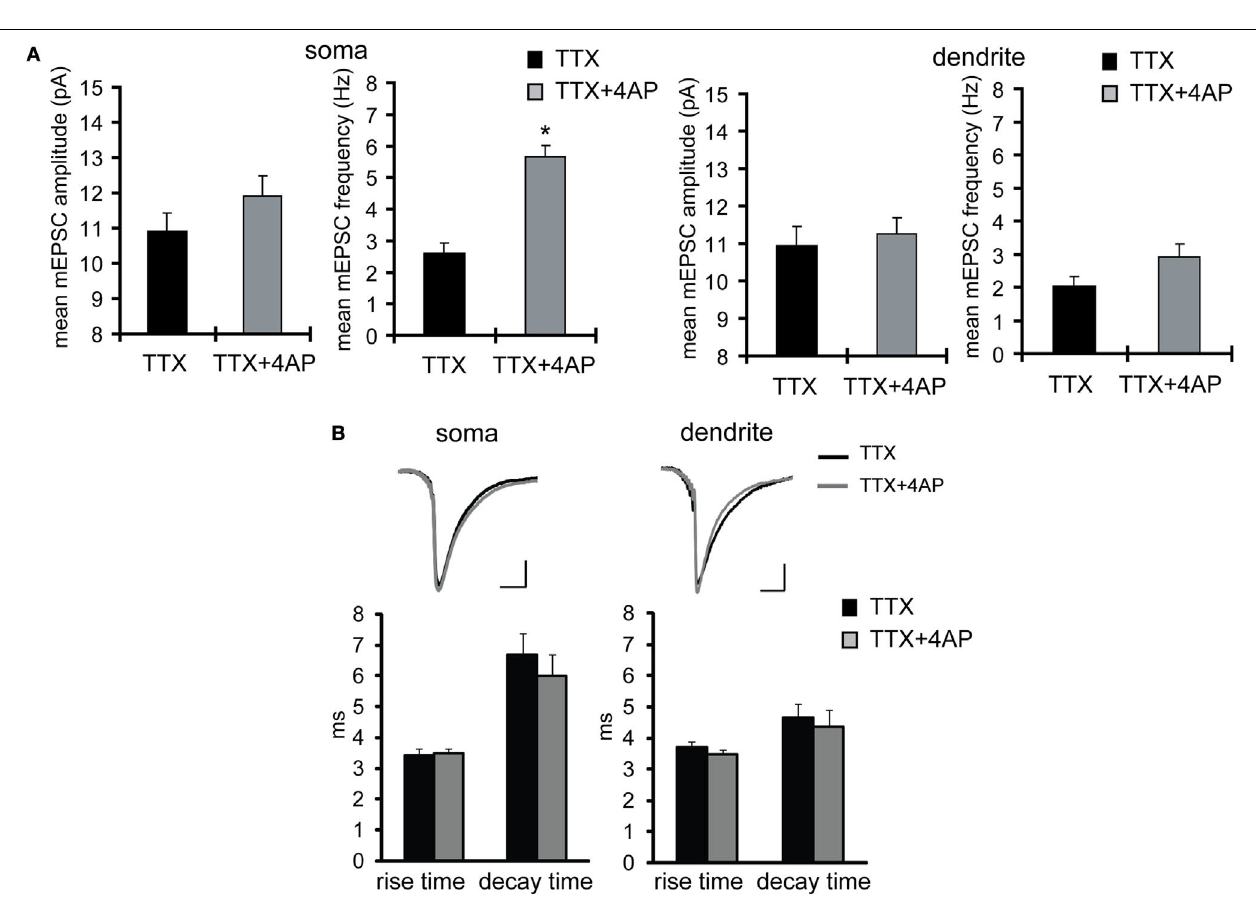
FIGURE 3 | The kinetics of the mEPSC waveform is not signifi cantly different between TTX- and TTX + 4AP-treated slices. (A) The data in Figures 1A,B were reanalyzed using a different program for mEPSC detection (Mini Analysis, Synaptosoft), which is based on threshold-cutting for event amplitude and area, rather than template-matching as used in Figure 1 (Clampfi t 9, Molecular Devices). The same pattern of results was